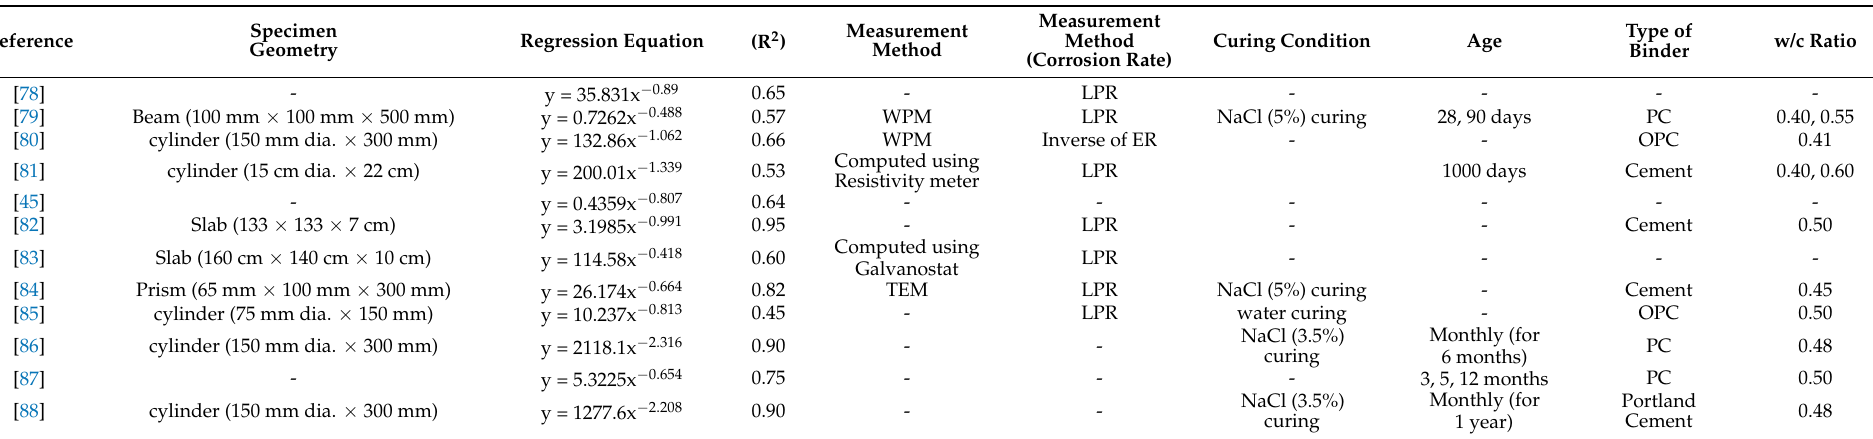
Table 2. Details of specimens used from different references for the correlation of electrical resistivity and corrosion rate, including the specimen geometry, regression equation, measurement method, curing condition, age, type of binder, and w/c ratio.